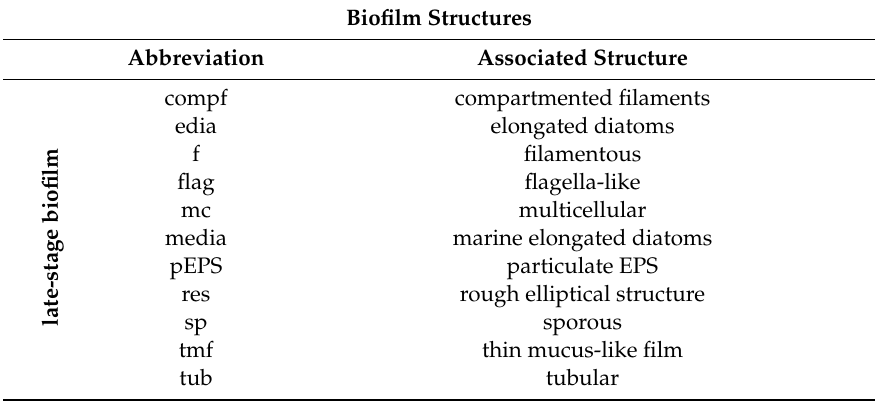
Table 2. Summary of the biofilm structures. Abbreviations and associated structures from late and early stage biofilm formation were observed in SEM